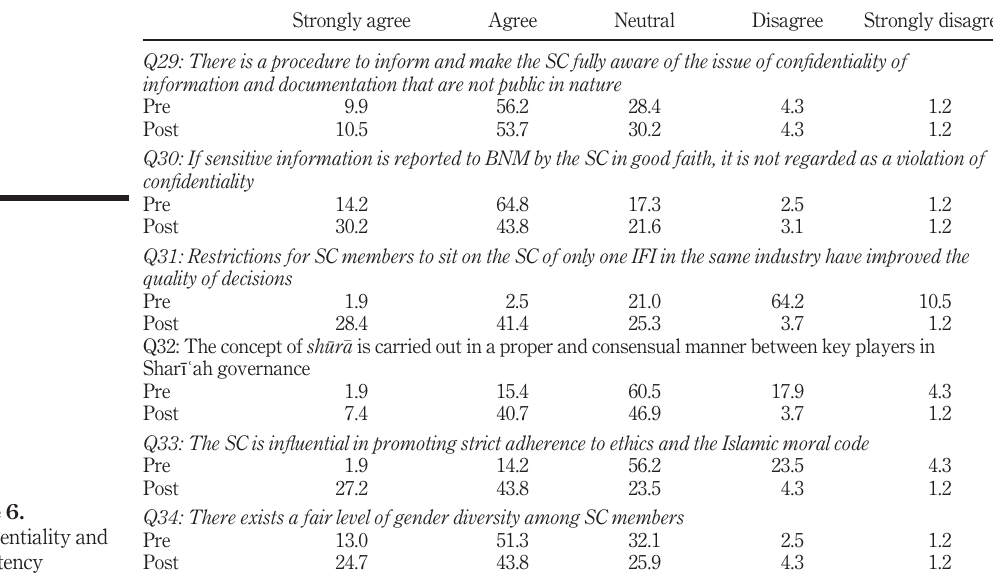
Table 6. Con fi dentiality